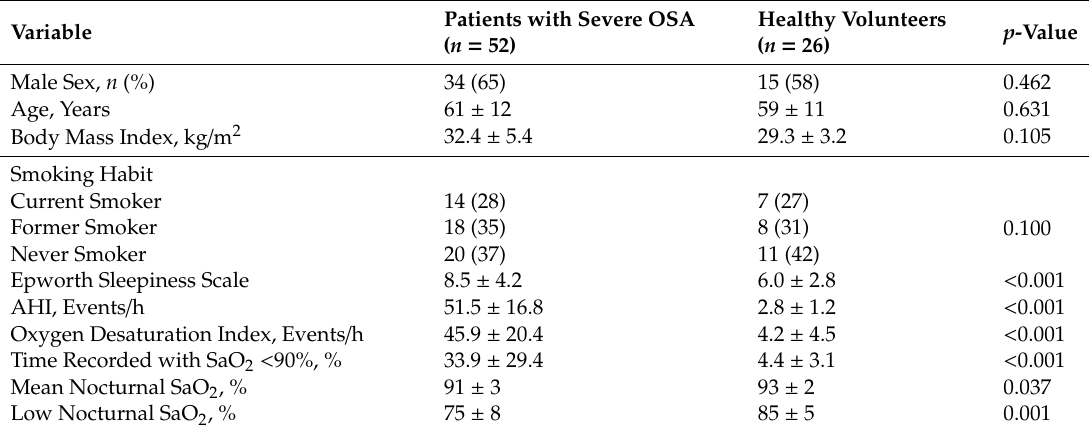
Table 1. General Characteristics of the Study